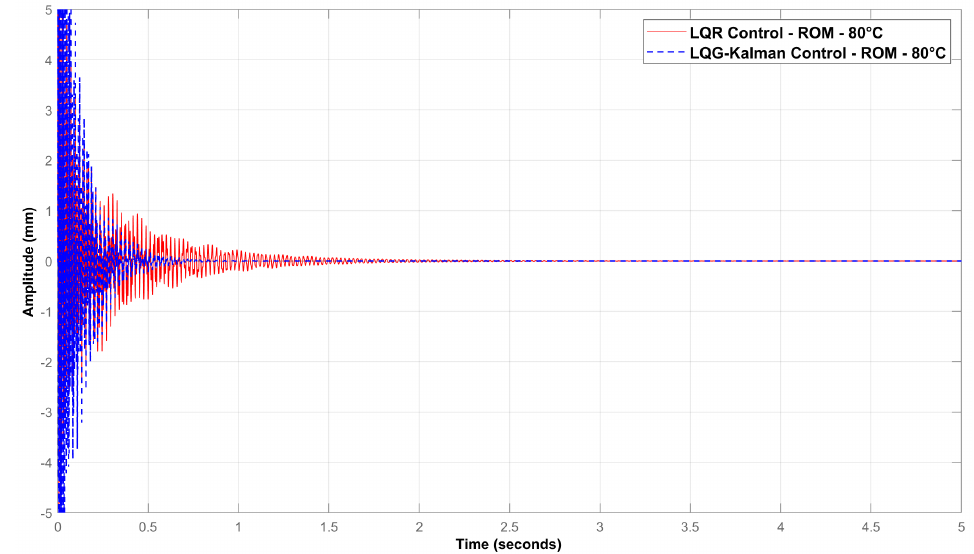
Figure 7. Comparison of impulse responses of LQG-Kalman and LQR controls in reduced model for T = 80 ◦ C with 4 distributed pairs of sensor/actuator and 8 selected sensors nodes.